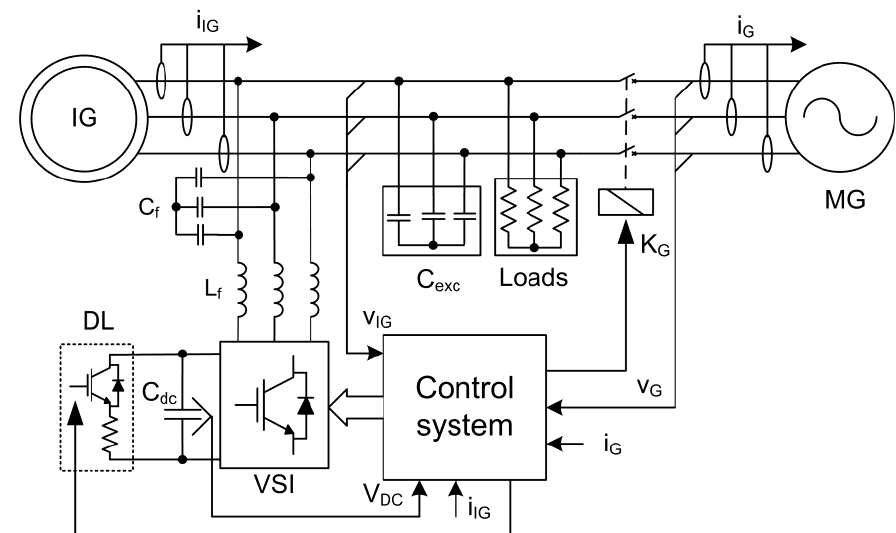
Figure 2. IG system configuration.